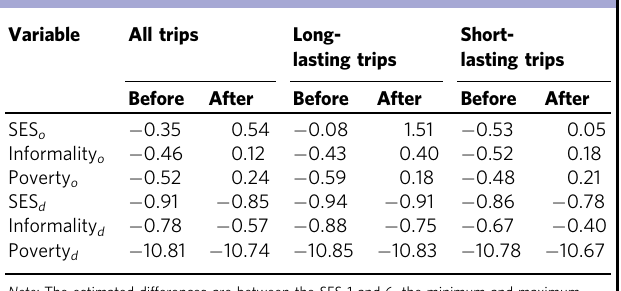
Table 1 Relative differences in the estimated mobility fl ows before and after the implementation of lockdown policies for different socioeconomic conditions at the origin and destination.